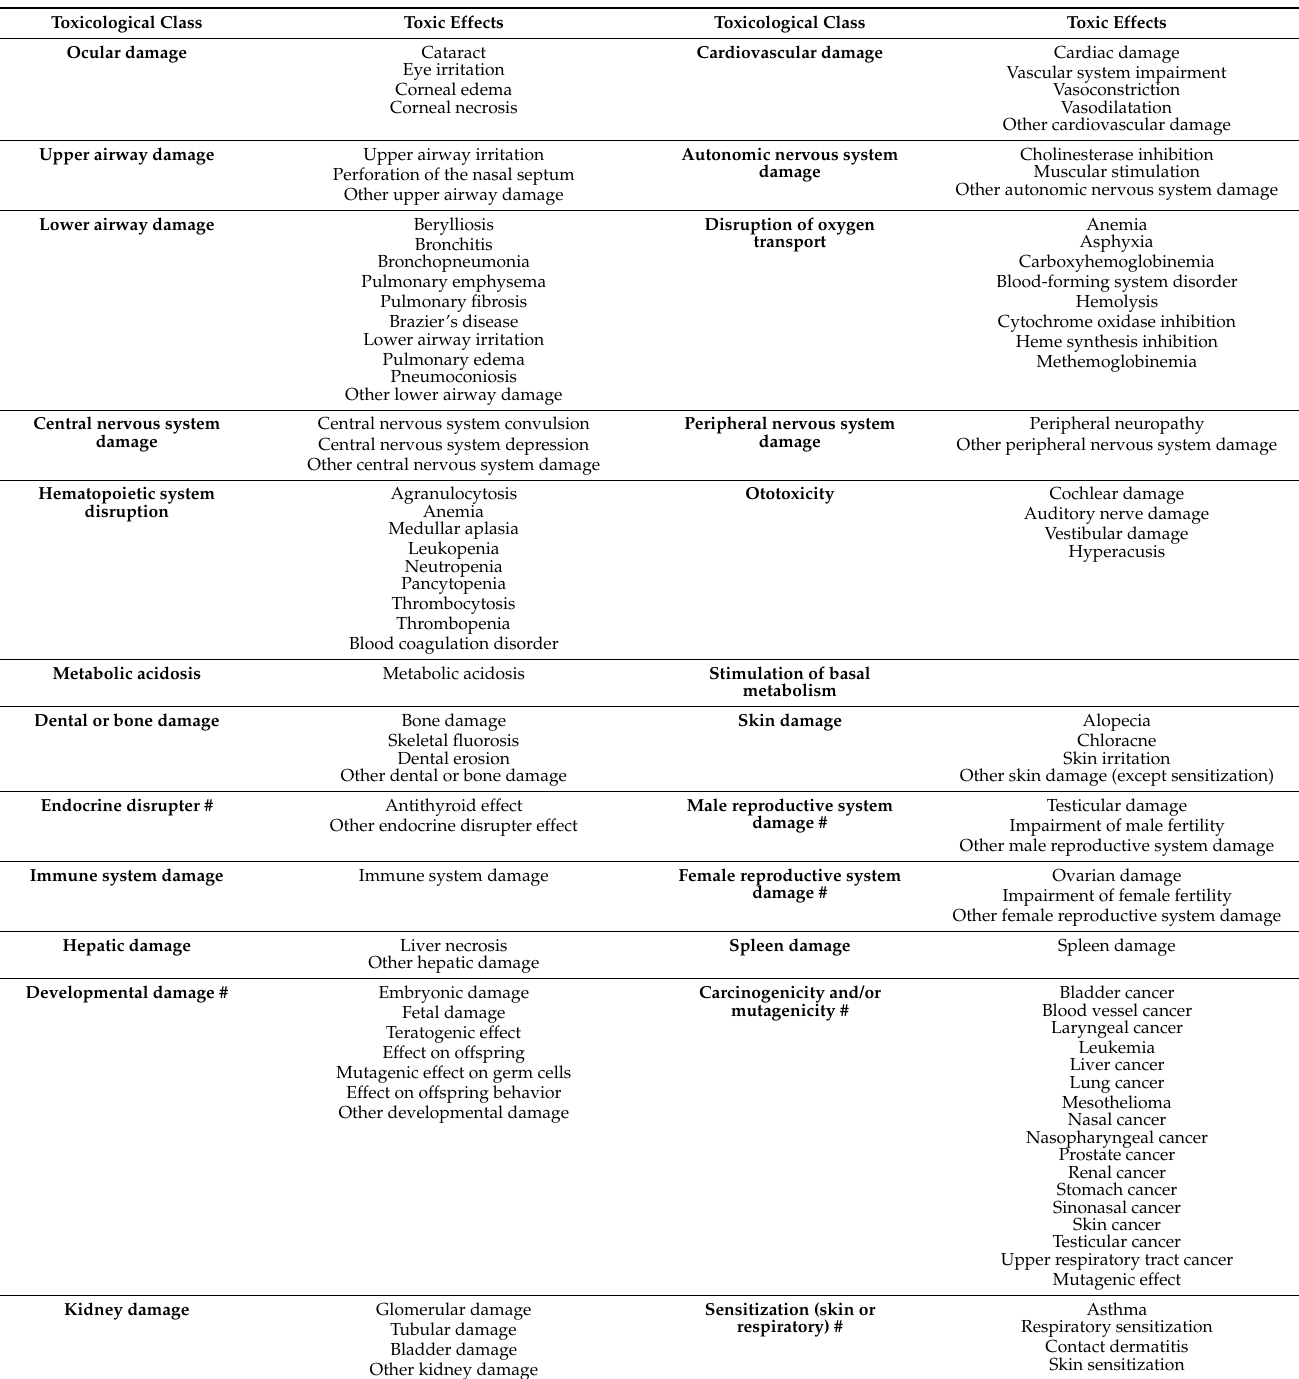
Table 1. MiXie toxicological classes and associated toxic effects (# non-additive toxicological